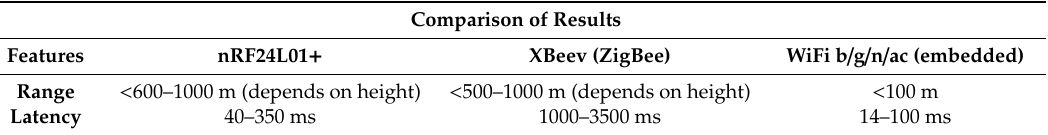
Table 3. Module performance.